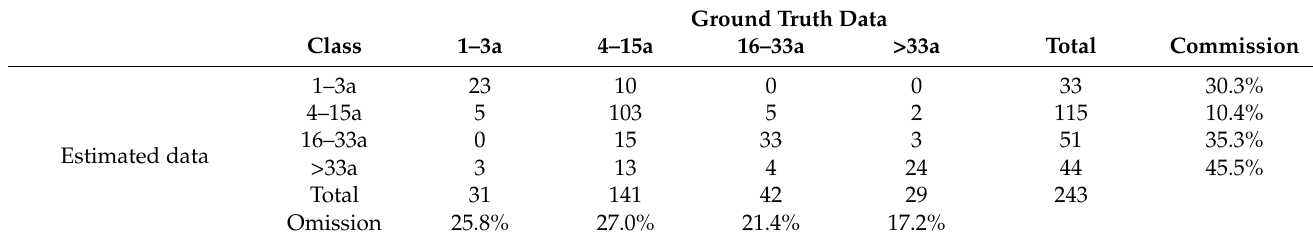
Table 3. Confusion matrix between estimated data and ground/truth